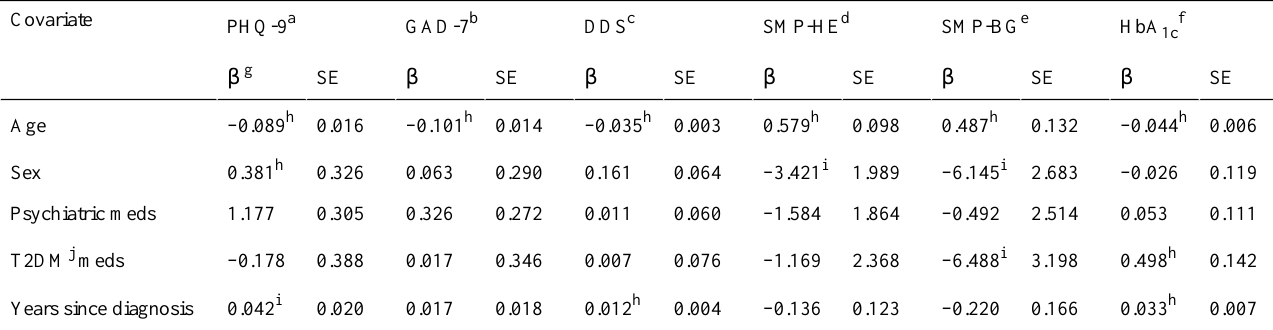
Table 5. Mixed model repeated measure fixed effects of covariates on change over time in secondary outcome